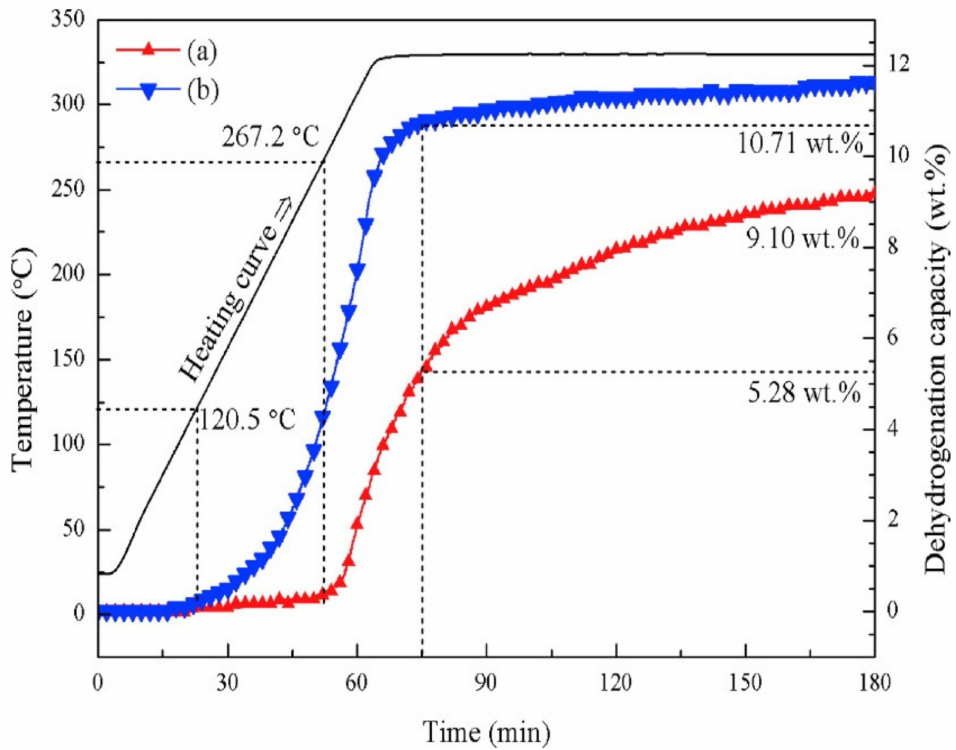
Figure 11. Isothermal dehydrogenation results for ( a ) pristine Mg(BH 4 ) 2 and ( b ) 40Ti 3 C 2 -doped Mg(BH 4 ) 2 composite at 330 ◦ C